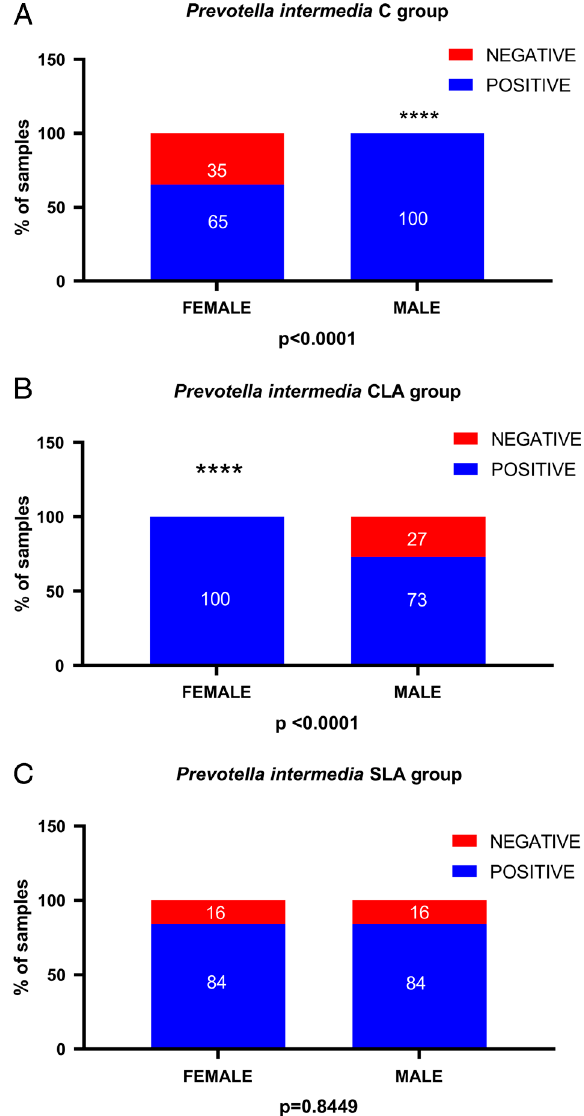
Figure 5. In P. intermedia , C group showed 100% of positivity in males. However, the CLA group had 100% of positivity for the female gender, meanwhile, SLA showed no significant differences between